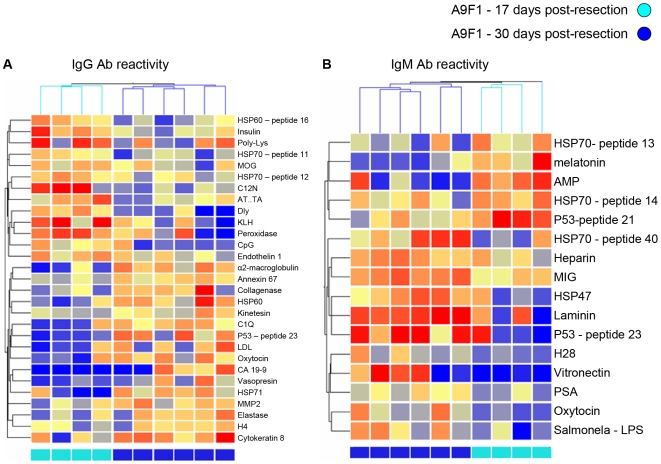
Clustering of antibody reactivities discriminates between mice following resection of the A9F1 clone at different time points.Hierarchical clustering of IgG (A) and IgM (B) reactivities 17 and 30 days after resection of the A9F1 tumors performed at 8 mm3. The separating antigens were chosen by the Wilcoxon rank-sum test (see supplementary Table S3III, Supplementary Data). A color code denoting early (light blue) and late (blue) time points is shown. The color scale shows the relative degree of antibody binding from low (dark blue) to high (dark red). The IgG and IgM reactivities both separated the groups.